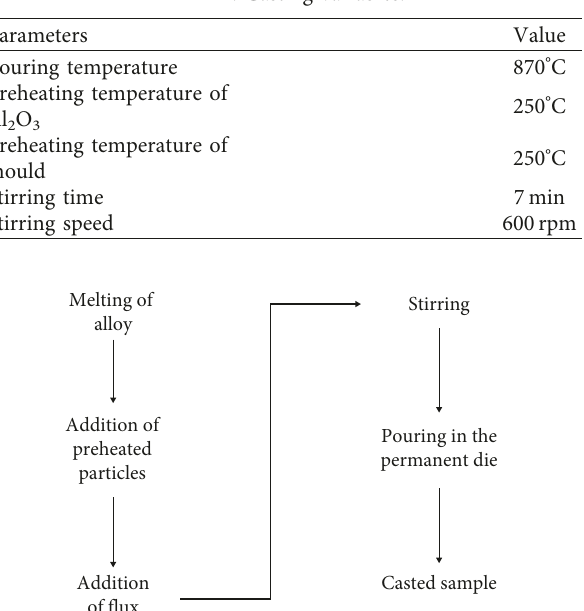
Figure 1: Steps involved in the production of